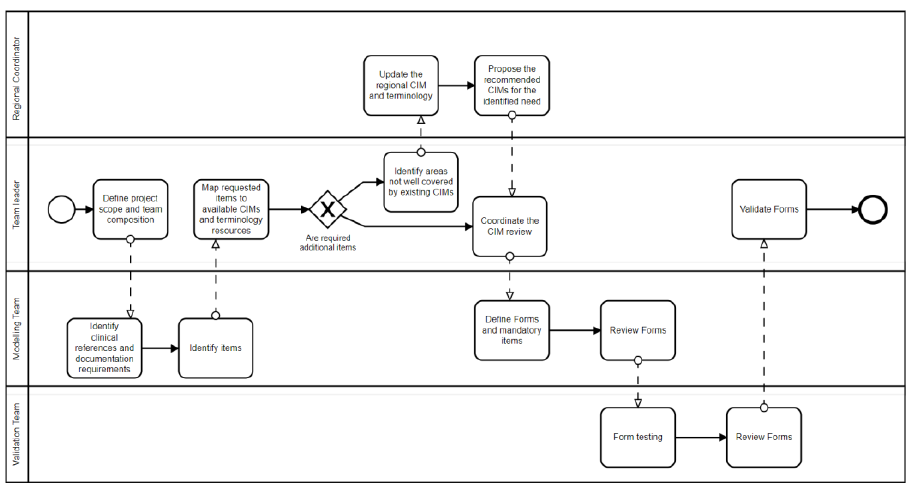
Figure 3. Representation of the clinical information modeling Process implemented in the MedicalForms system.